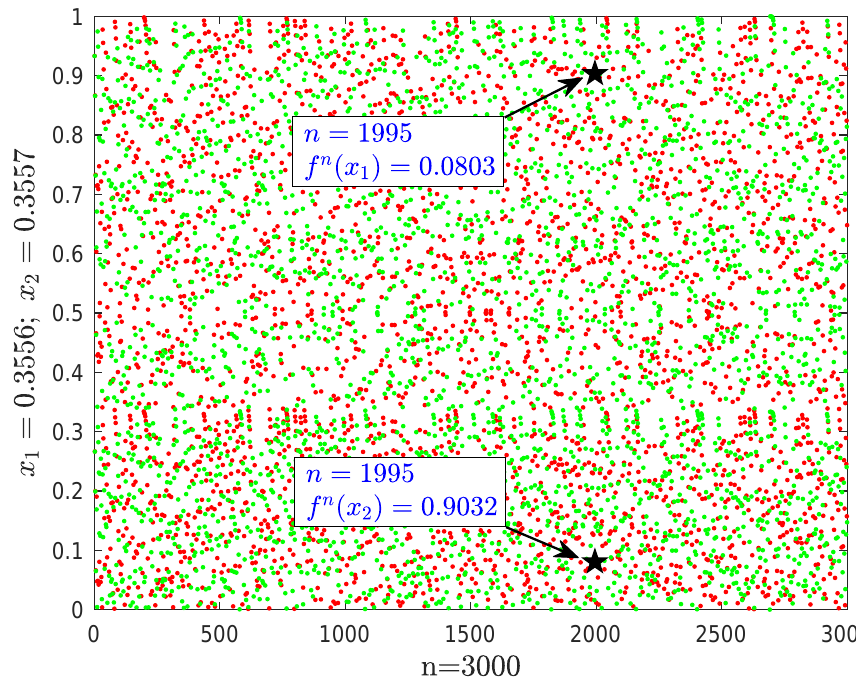
Figure 1. Chaotic behaviors of h in Example 1 with the initial data x 1 = 0.3556, x 2 = 0.3557 and n =